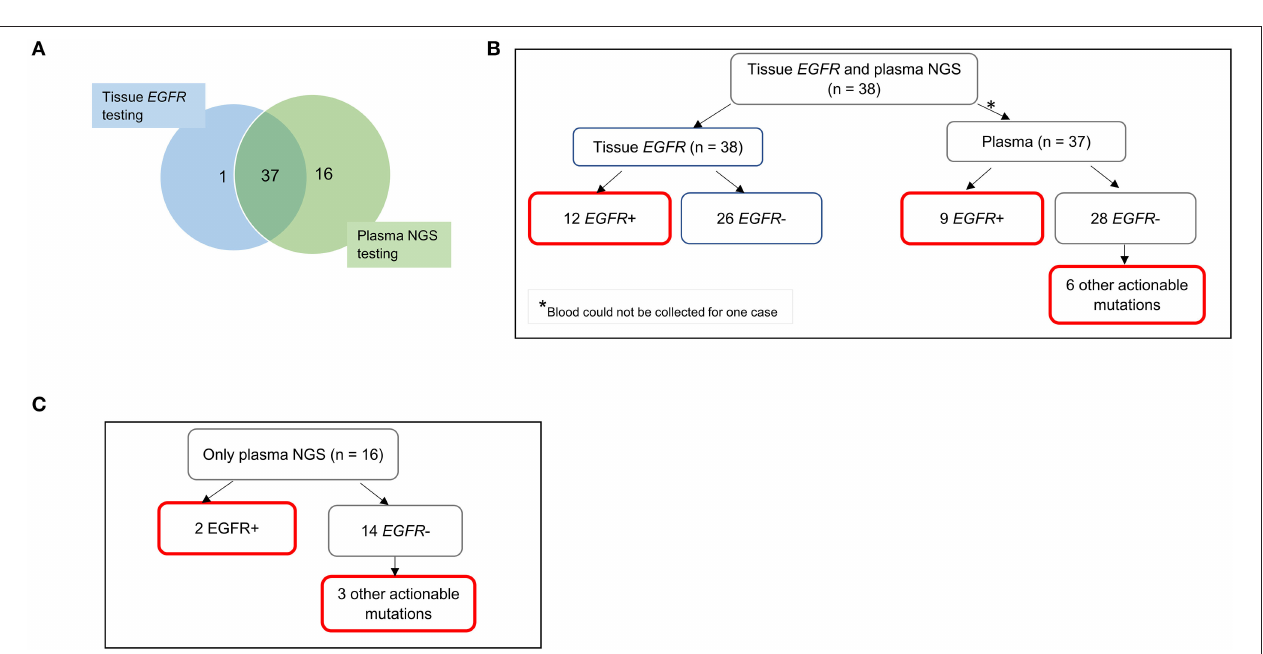
FIGURE 2 | Diagnostic yield from molecular testing of tissue and plasma samples for 54 patients with NSCLC. (A) Nearly all 38 patients with informative tissue EGFR testing underwent plasma NGS testing (except one). An additional 16 patients had only plasma NGS testing done, due to inadequate tissue biopsy samples for molecular testing or non-informative results from tissue testing. (B) Findings of EGFR sensitizing mutations and other actionable mutations in cases with both tissue EGFR and plasma NGS results. Six other actionable mutations from plasma NGS testing included MET exon 14 skipping ( n = 1), BRAF p.V600E ( n = 1), BRAF p.K601E ( n = 1), KRAS p.G12D ( n = 2), and EGFR exon 20 insertion ( n = 1). (C) Clinically actionable findings in cases with only plasma NGS testing. Boxes outlined in red indicate clinically actionable diagnostic yield from all testing modalities. EGFR, epidermal growth factor receptor; NGS, next-generation sequencing.